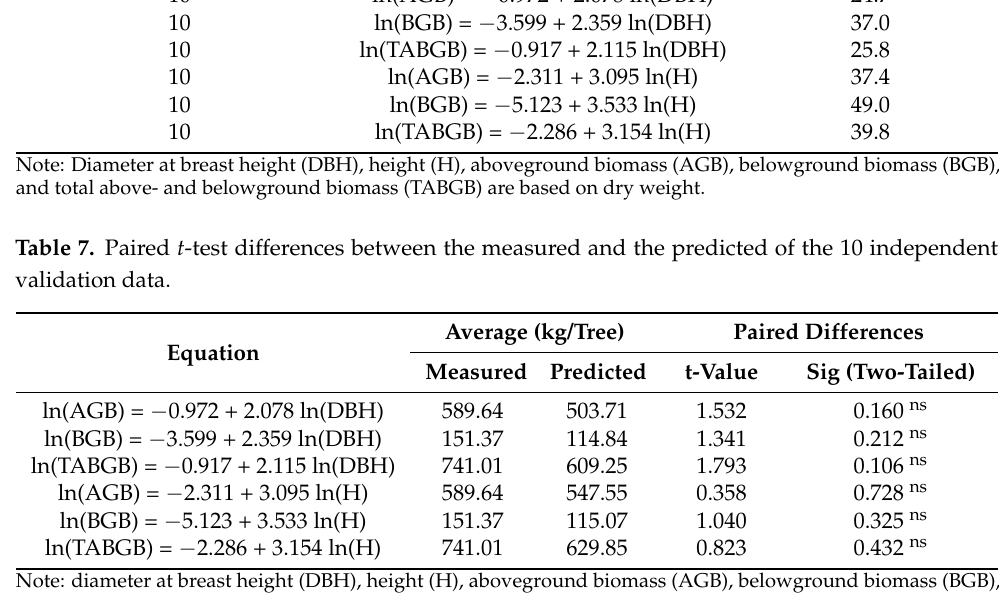
Table 8. The confidence interval of the mean of various allometric models. Parameter